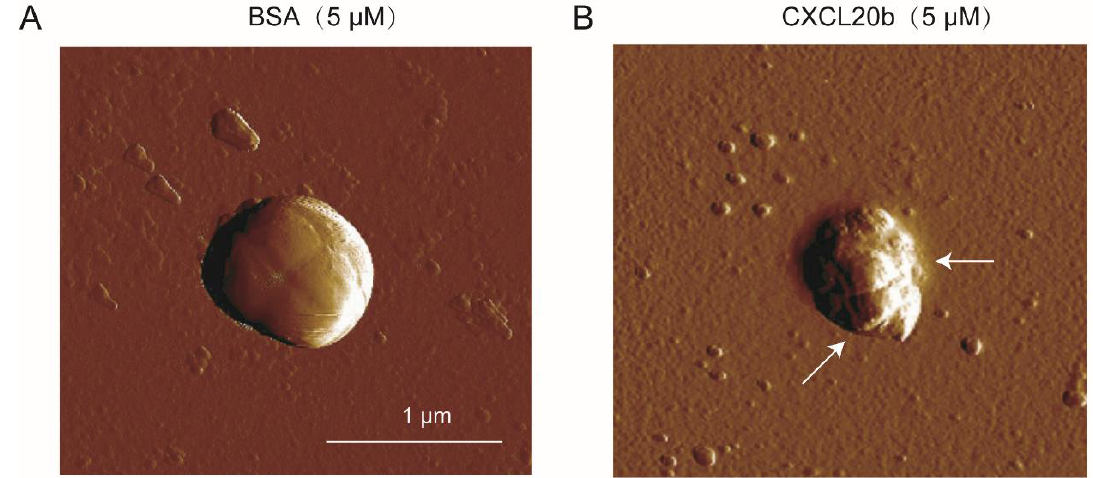
Figure 5. CXCL20b could cause S. aureus (ATCC 26923) cell membrane disruption in contrast to BSA (negative control). S. aureus (ATCC 26923) incubated with 5 µM BSA ( A ) and grass carp CXCL20b ( B ) for 15 min was observed by AFM. The arrow indicates the area of membrane rupture.